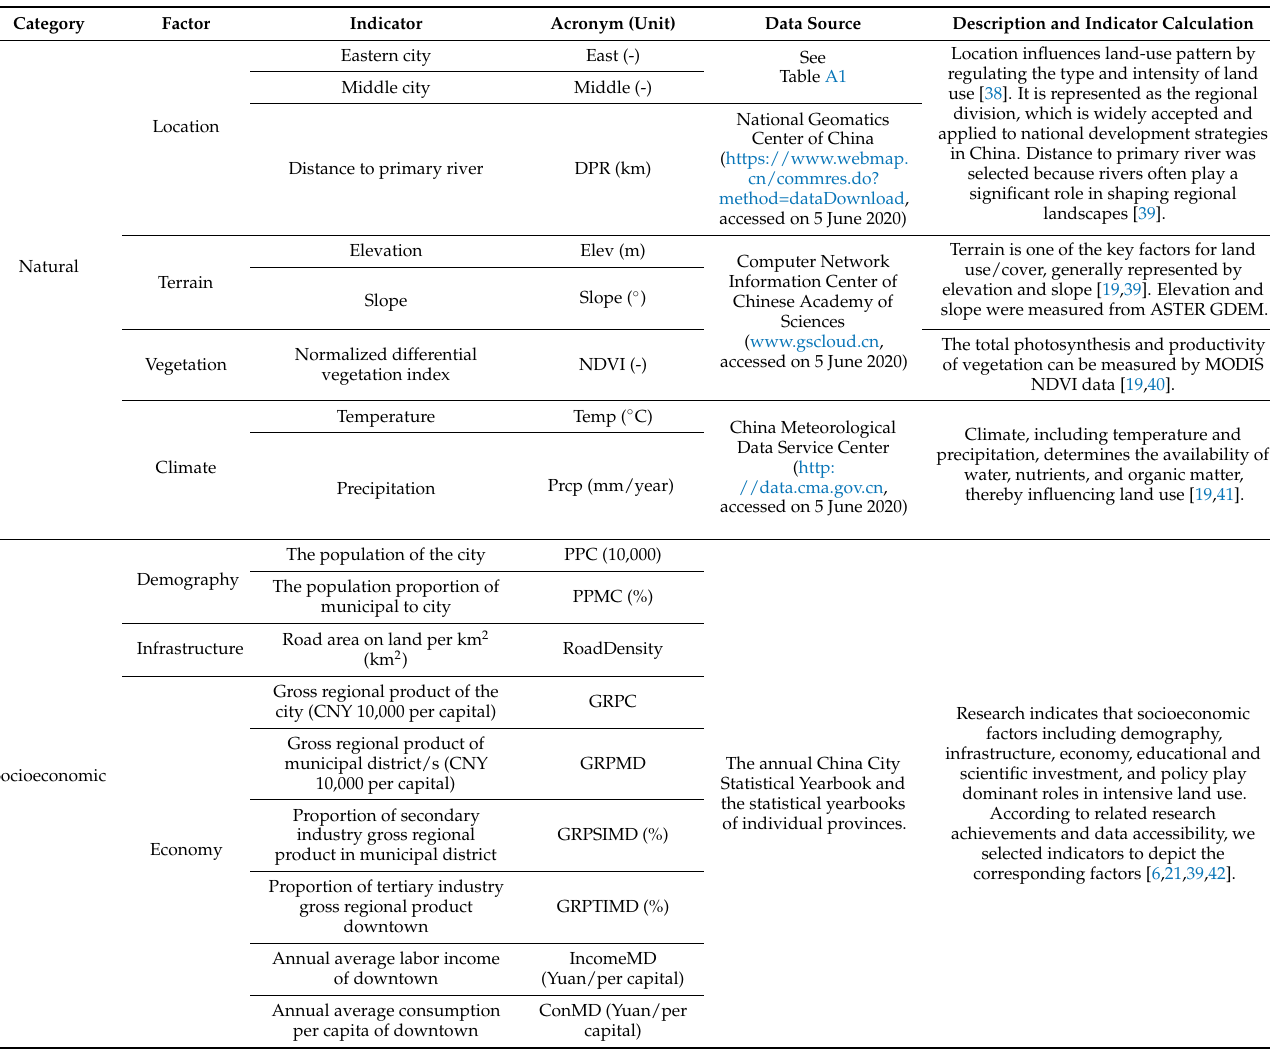
Table 1. Indicator system containing both natural and socioeconomic factors influencing land-use intensity in Chinese cities. Category Description and Indicator